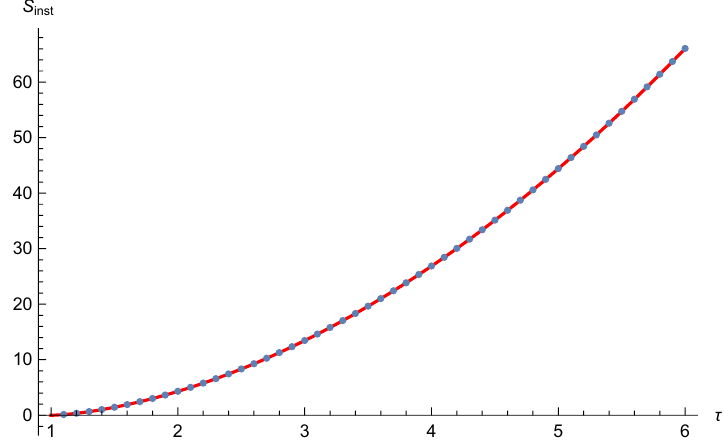
Figure 1 . Plot of the instanton action S inst ( (cid:28) ). The dots are the exact values of the right hand side of (2.14) for N = 500, while the red curve represents the analytic form of S inst ( (cid:28) ) in (2.11). holographic dual of the SYK model, called JT string in [6], and see how the D-branes in the JT string are related to the ramp-plateau